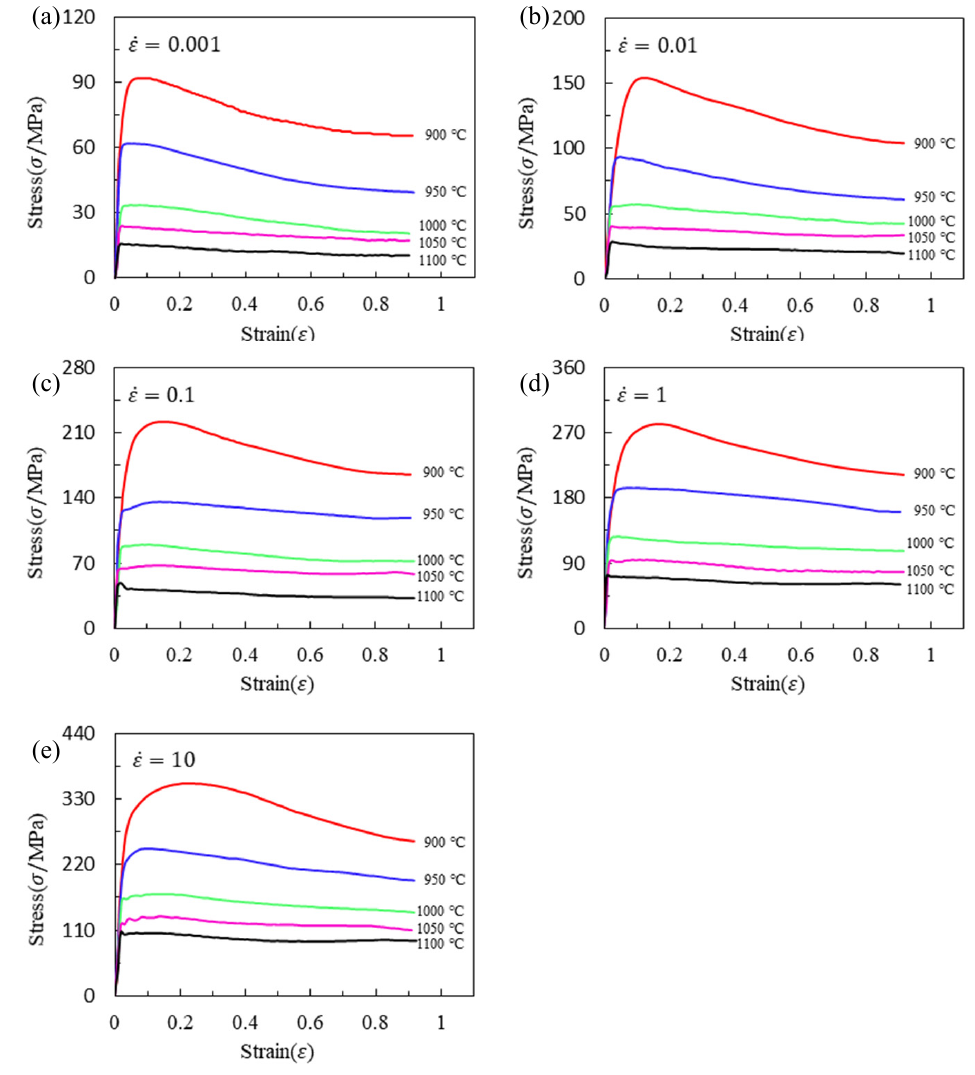
Figure 2. Flow stress–strain curves of Ti6242s alloy during hot compression at strain rates of ( a ) 0.01 s − 1 ; ( b ) 0.1 s − 1 ; ( c ) 1 s − 1 ; ( d ) 10 s − 1 ; ( e ) 10 s − 1 .